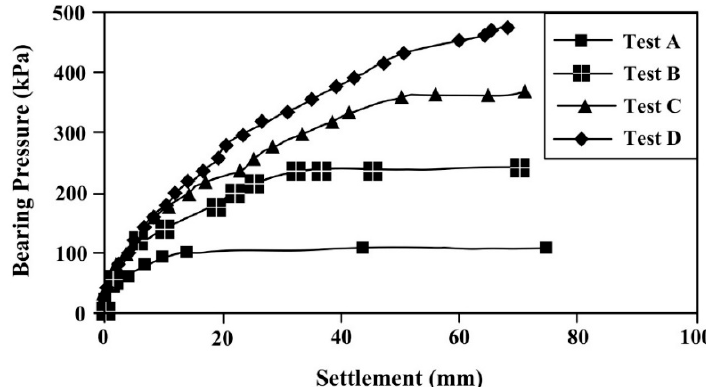
Figure 6. Variation in bearing pressure and settlement for a 167-mm-thick base under monotonic load tests (modified from Subaida et al. [37]). Minerals 2020 , 10 , x FOR PEER REVIEW 12 of 22